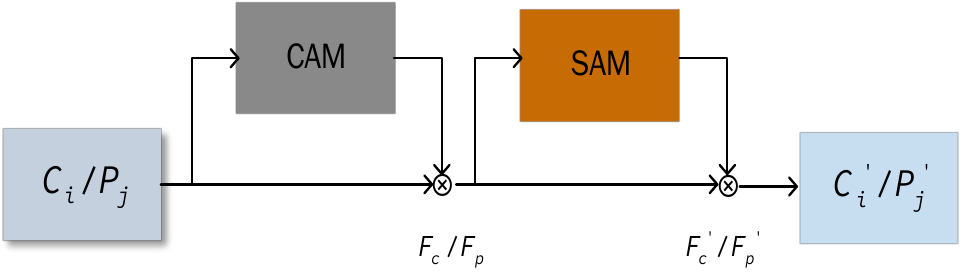
Figure 4. Convolutional block attention module .